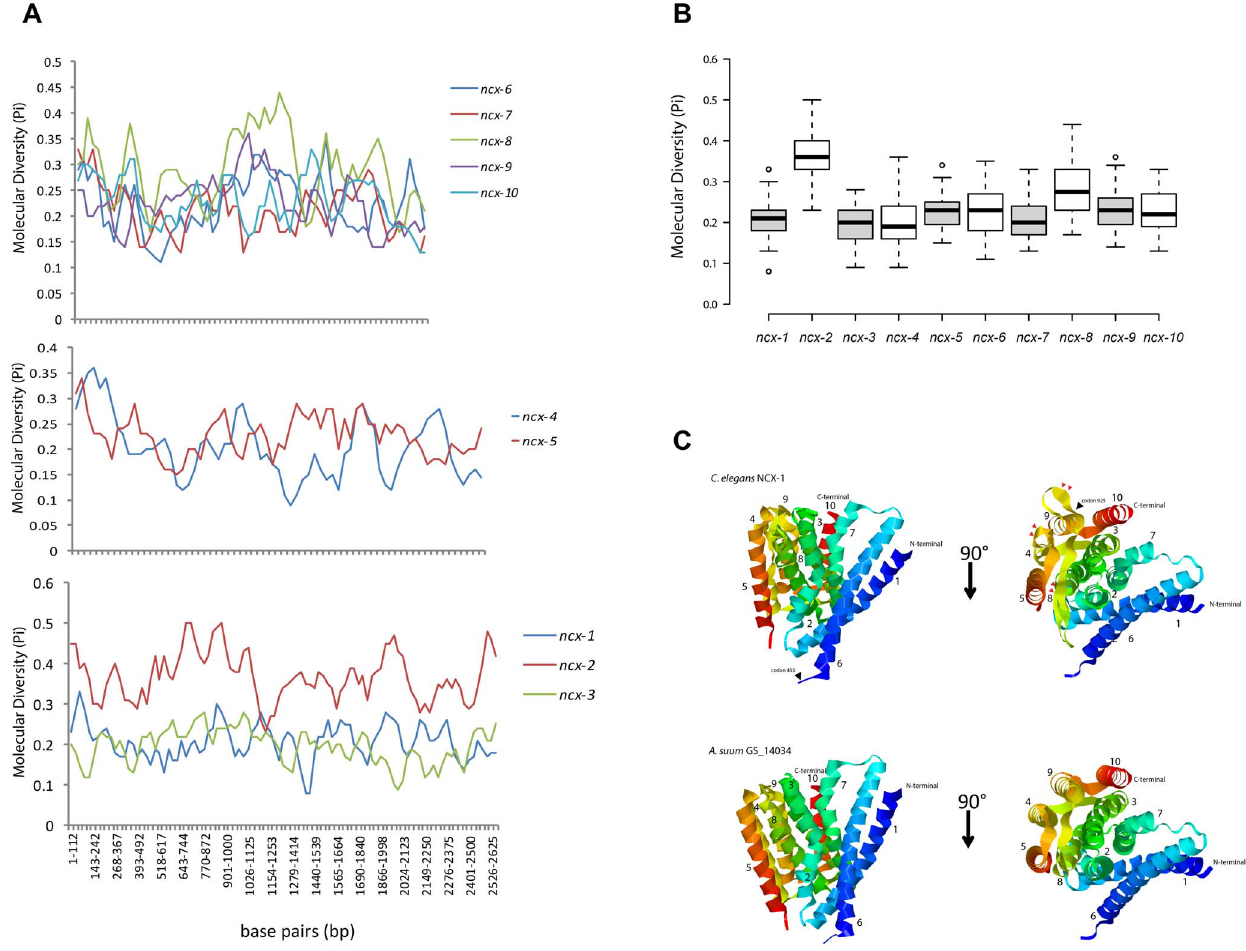
Figure 3. Sequence and structural analysis of nematode exchangers. ( A ) Sliding window analysis of nucleotide diversity using DnaSP version 5 [47] with 100 bp windows and 25 bp steps for CCX (upper graph), NCKX (middle graph), and NCX exchanger (lower graph) gene pairs between C. elegans and C. briggsae . ( B ) Box plot analysis of molecular diversity for each ncx gene ( ncx-1 to ncx-10 ) between C. elegans and C. briggsae . Whiskers extend to data points that are less than 1.5 6 interquartile range away from 1st/3rd quartile; center lines show the medians and outliers are shown as dots. ( C ) Ribbon model of NCX-1 from C. elegans and an NCX-3 ortholog from A. suum (GS_14034). N and C termini are indicated, and red arrowheads refer to structural differences between each NCX. Numbers refer to the transmembrane (TM) domains. Extracellular side is up in left views. The position of two candidate sites in NCX-1 undergoing episodic diversifying selection are indicted - codon 455 and codon 925. In each case the right view is rotated by 90 u . Structural predictions were made using Phyre [48] and visualized using RasMol [49]. In each case the single highest scoring modelling template was the resolved NCX (NCX_Mj) structure (PDB: 3V5U) from Liao et al. [8].